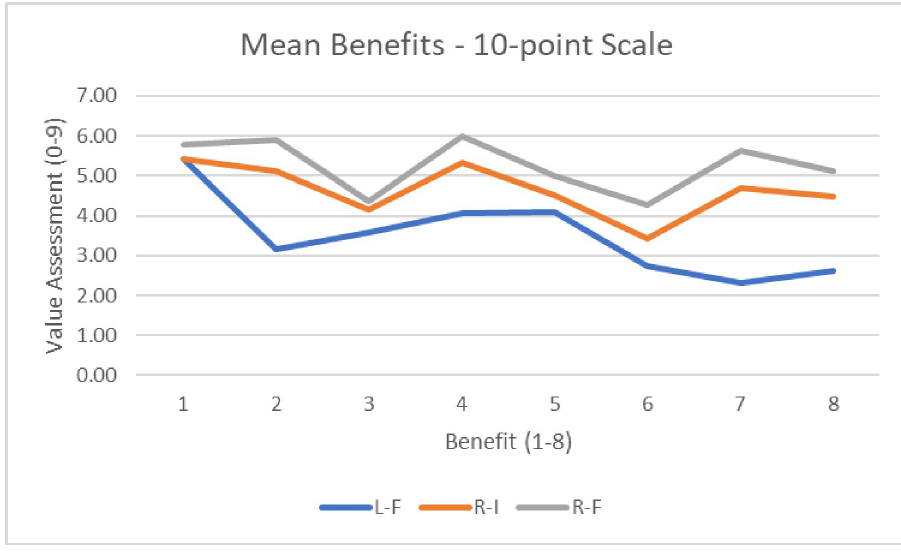
Fig 8. Average benefit value assessments for the 10-point